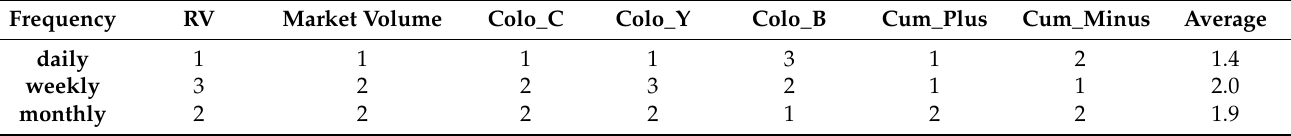
Table 4. Comparison of the importance of periods in each